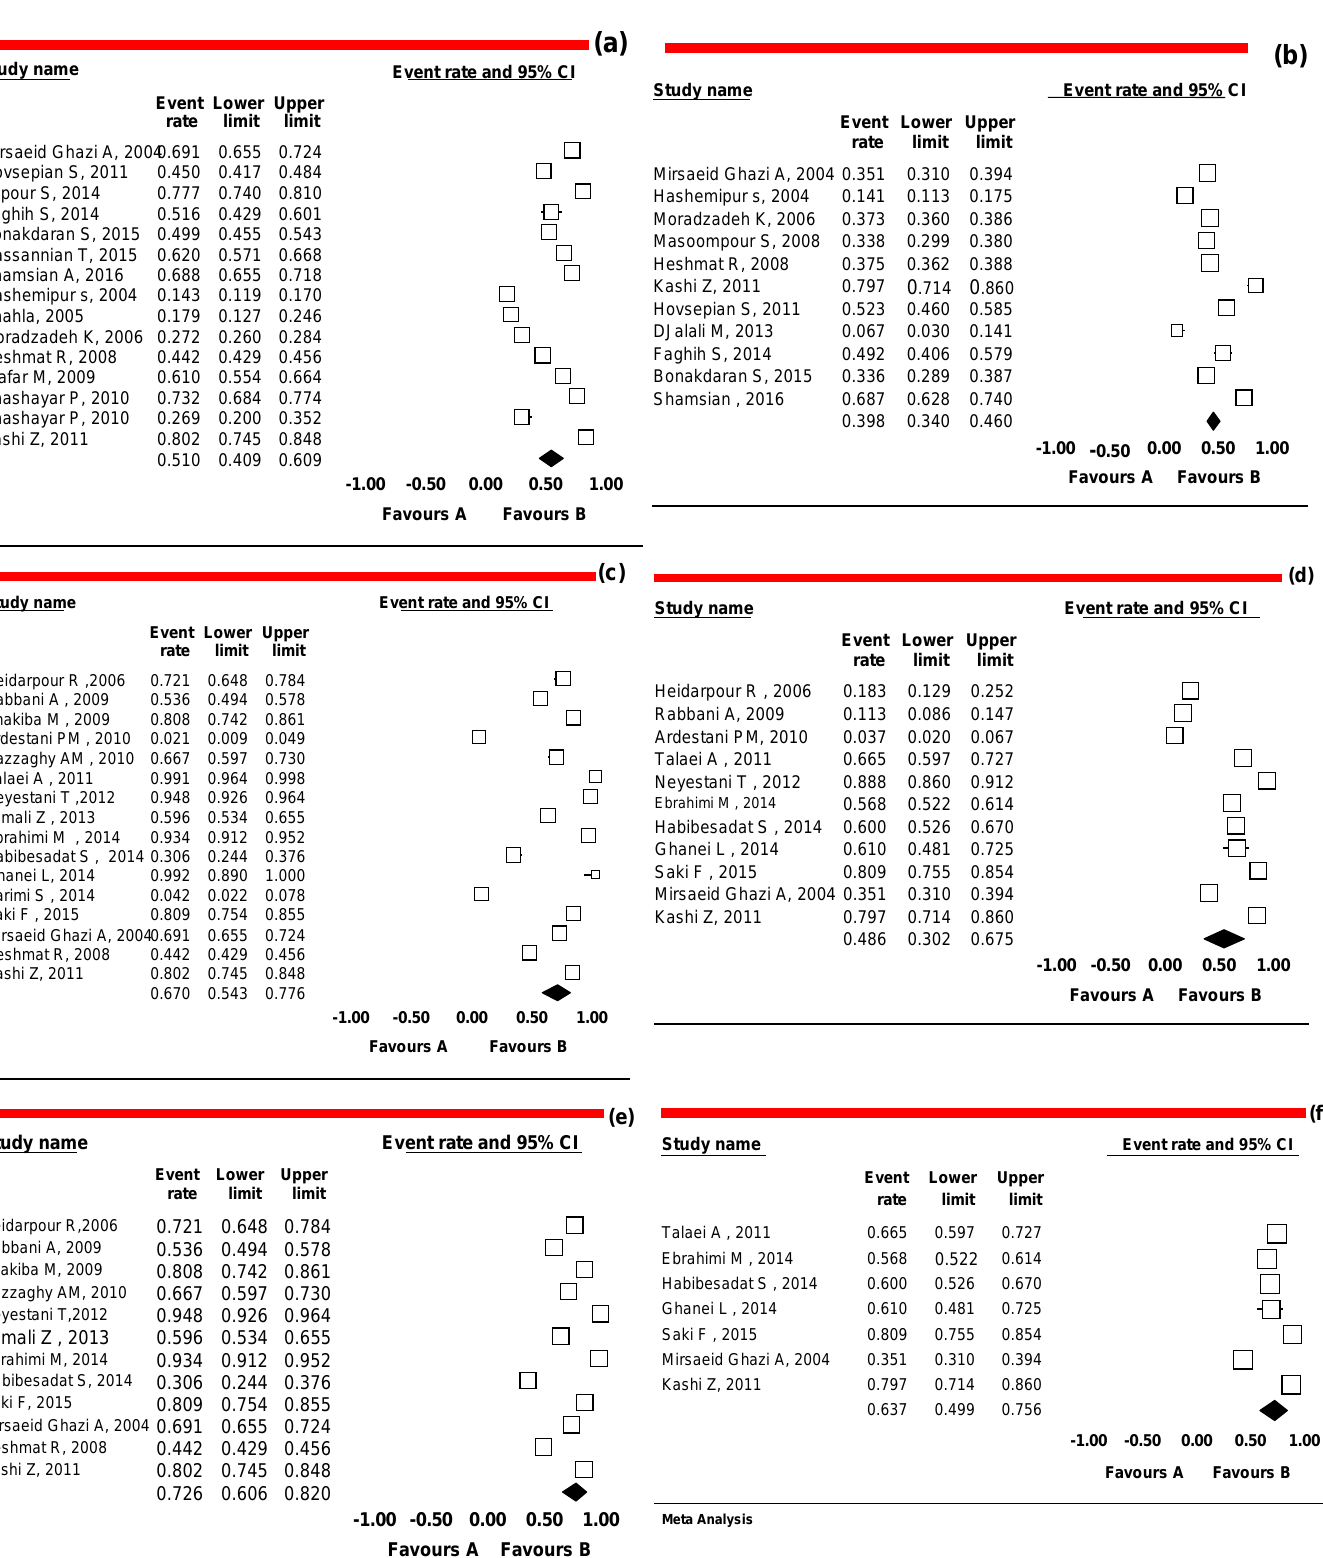
Figure 6. Meta-analysis of the prevalence of vitamin D deficiency (cut-off point: <20 ng/mL) (a) Females, more than 18 years old, (b) Males, more than 18 years old, (c) Females, less than 18 years old, (d) Males, less than 18 years old, (e) Females, less than 18 years old, after removing four extreme data (Ardestani, Karimi, Talaei, Ghanaei), and (f) Males, less than 18 years old, after removing four extreme data (Ardestani, Rabbani, Heidarpour,